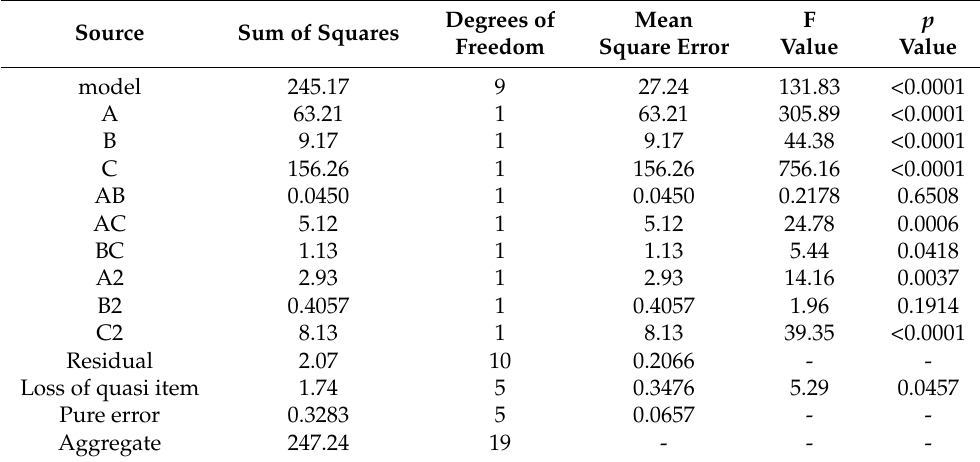
Table 4. Results of regression analysis of variance of electricity production.